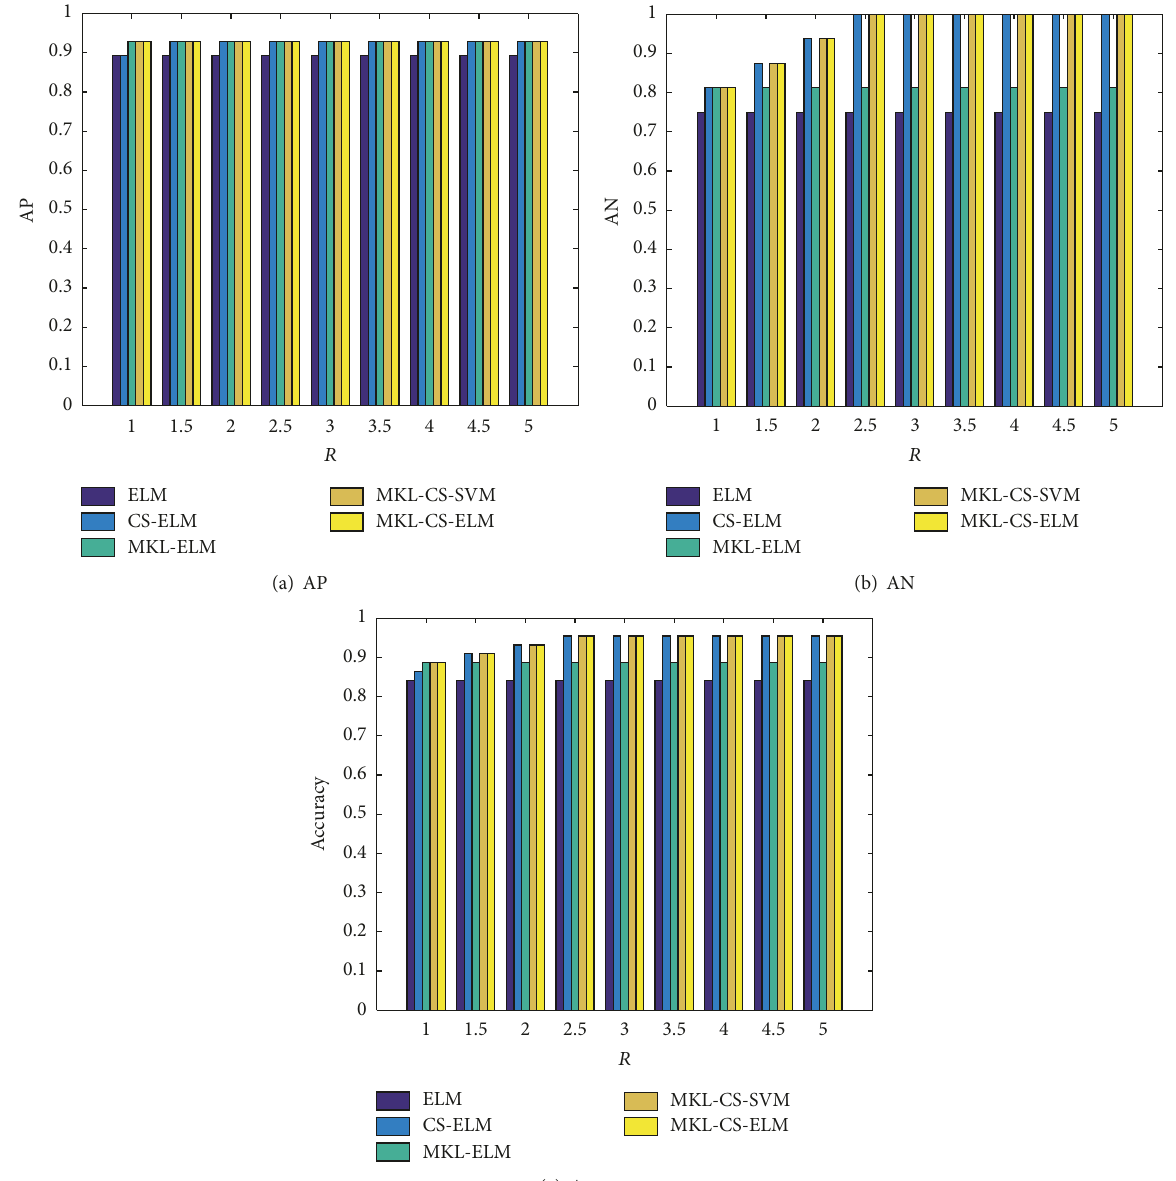
Figure 11: The recognition results of five classification models in threshold